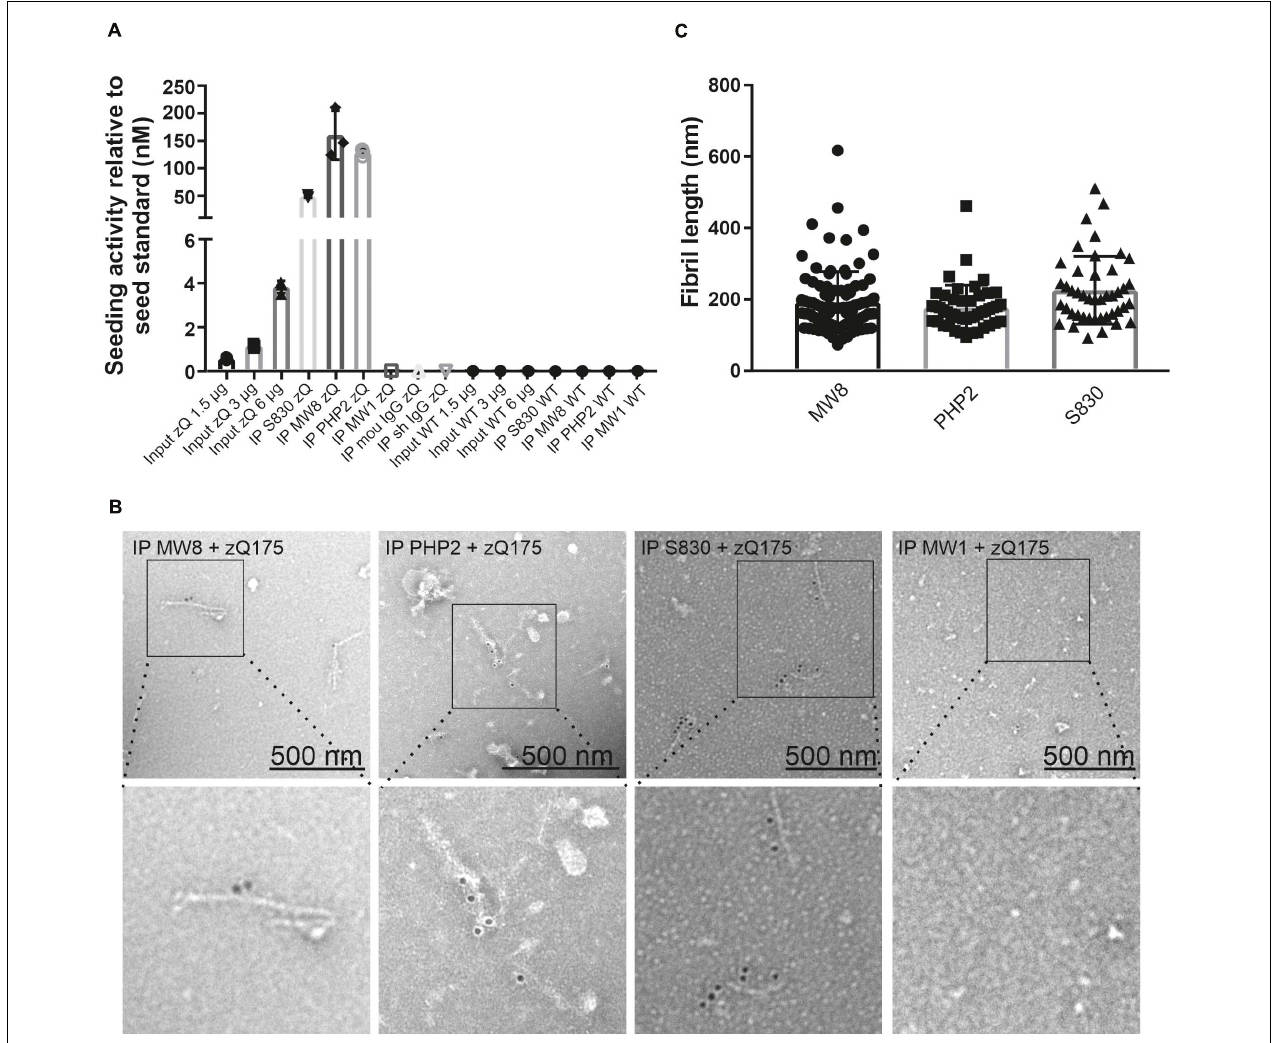
FIGURE 3 | Quantification of mHTT seeding activity and detection of mHTT fibrils in immunoprecipitates enriched from zQ175 mouse brain homogenates. (A) Immunoprecipitates and total brain homogenates (input) prepared from WT and zQ175 (zQ) mice were analyzed by FRASE assay. Seeding activities were normalized to the seed standard. Data are mean ± SD of three technical replicates. (B) TEM analysis with aAgg-immunogold labeling of eluates derived from S830, PHP2, and MW8 immunoprecipitations of zQ175 mouse brain homogenates. As a control, an eluate from a MW1 immunoprecipitation experiment with a zQ175 brain homogenate is shown. Pictures in the bottom row show magnifications of areas indicated in pictures in the top row. Fibril length was determined with the iTEM software (C) . For the MW8 IP, n = 95, for the PHP2 IP, n = 48 and for the S830 IP, n = 44 fibrils were measured. Mean fibril length is 192 nm ± 87 for the MW8 IP, 177 nm ± 63 for the PHP2 IP and 226 nm ± 95 for the S830